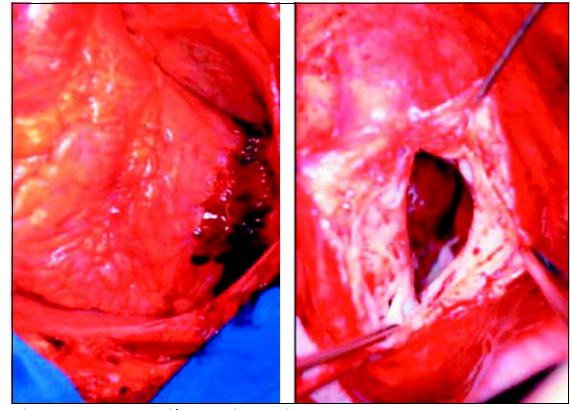
Fig. 2 – Rotura cardíaca